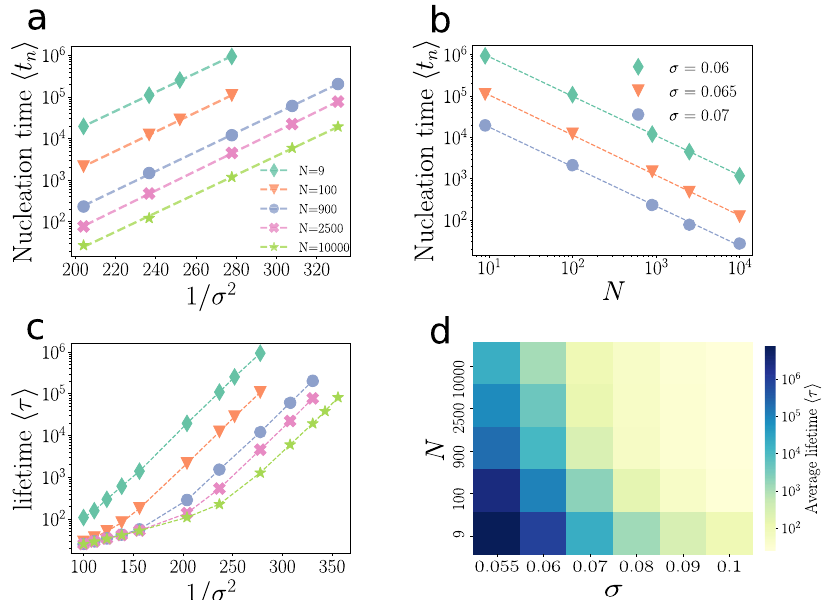
Fig. 3 The in fl uence of system size N and noise strength σ on transition modes and average lifetime 〈 τ 〉 . Initially, all of the nodes are at the low state x x 〈 t 〉 changes with noise strength for different system sizes L , and the time to switch to the high state H is measured. a The average nucleation time n N = 9, 100, 900, 2500,10,000. b The linear relationship between the average nucleation time 〈 t 〉 and N − 1 . c Two regimes with different slopes of ln h τ i n as a function of σ − 2 , which corresponding to two cluster modes. It shares the same legend as a . c and d summarize the effects of system size N and noise strength σ on the average lifetime 〈 τ 〉 . The increase of noise strength lowers the average lifetime. For the single cluster mode, the larger system requires less time to complete